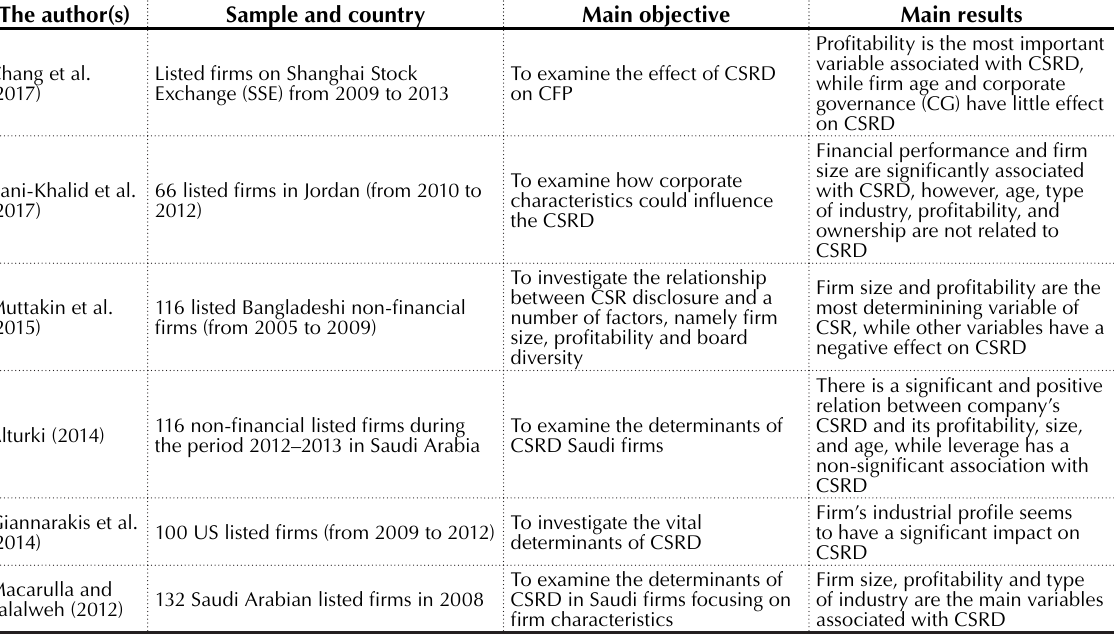
Table 1. List of some previous CSRD and CFP